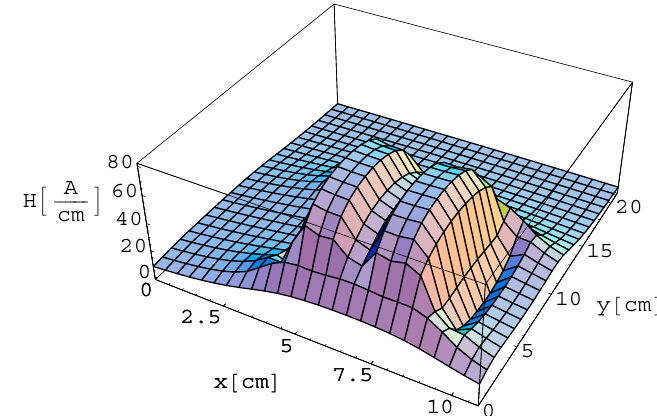
Figure 10. The distribution of magnetic field intensity along the line x = const of an unshielded busbar system with current symmetry.